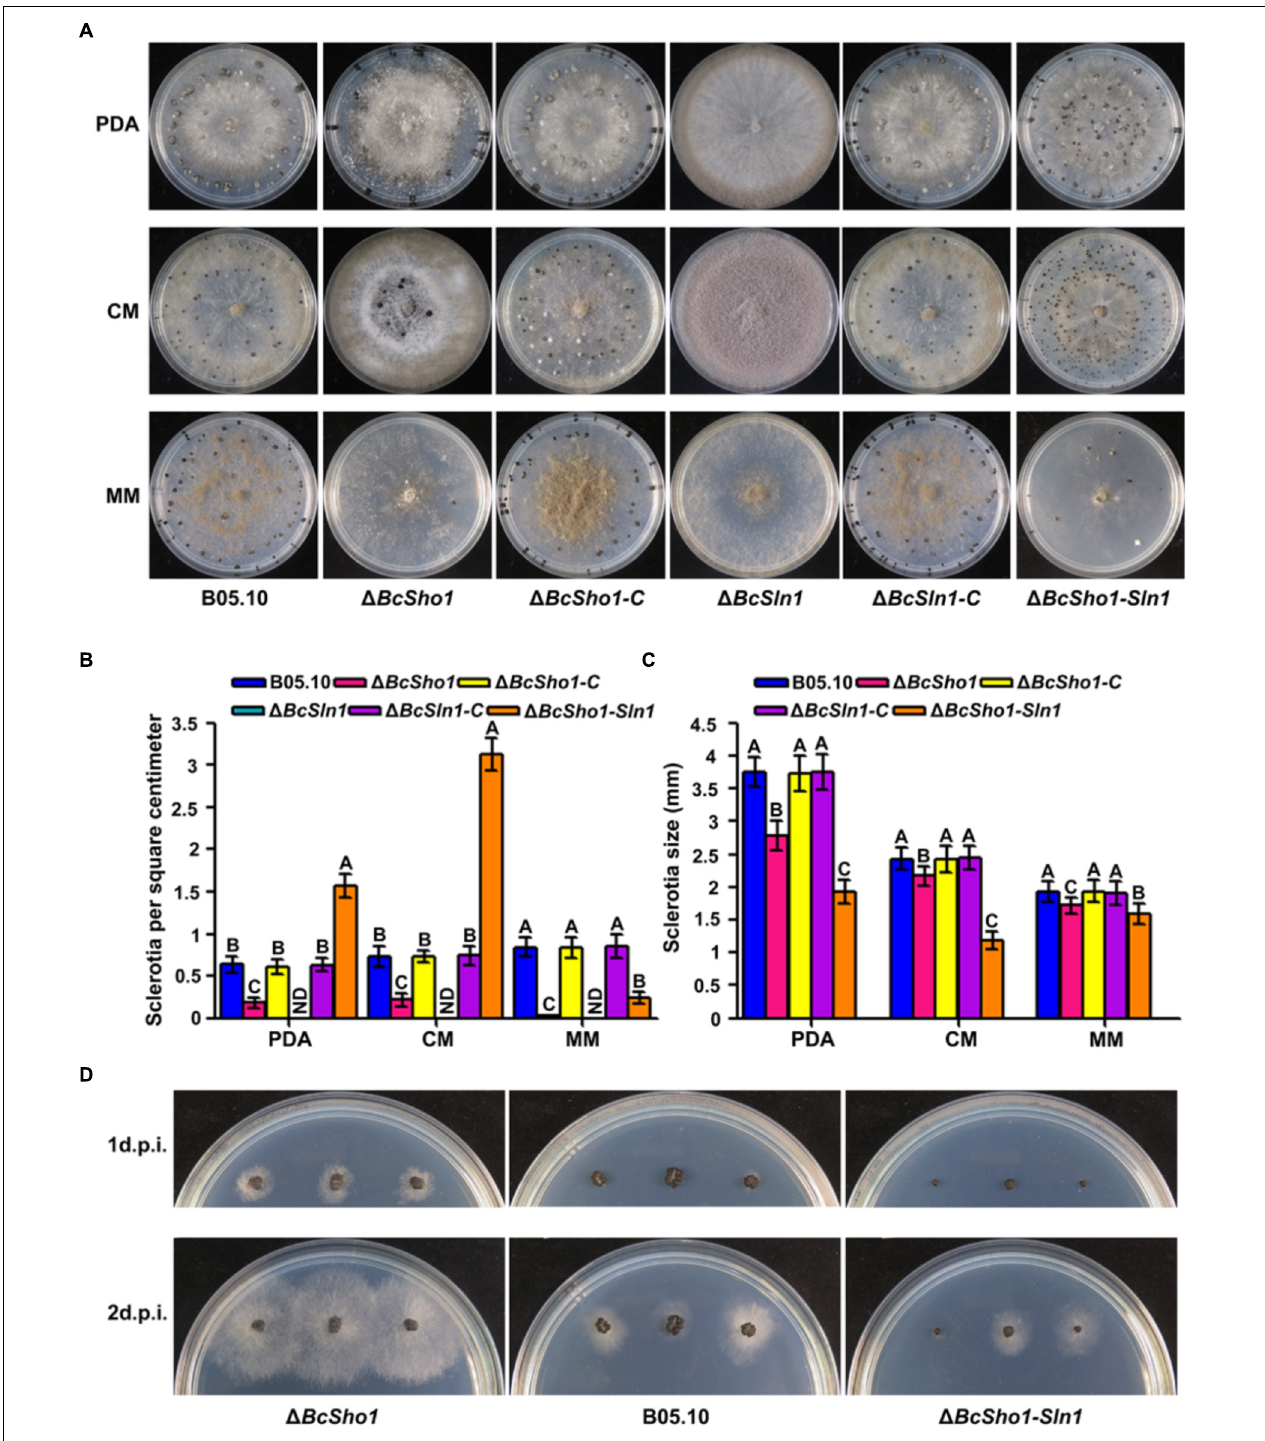
FIGURE 4 | Roles of BcSHO1 and BcSLN1 in sclerotial formation. (A) Colony morphology of sclerotial formation. B05.10, (cid:49) BcSho1 , (cid:49) BcSln1 , (cid:49) BcSln1-Sho1 , (cid:49) BcSho1-C , and (cid:49) BcSln1-C were cultured on PDA, CM and MM media at 4 ◦ C for 4 weeks in darkness. (B) The number of sclerotia produced by each strain on PDA, CM, and MM media. ND, not detected. Bars represent standard errors from three replications. Values on the bars followed by the same letter are not significantly different at P = 0.05. (C) The size of sclerotia produced by each strain. Bars represent standard errors from three replications. Values on the bars followed by the same letter are not significantly different at P = 0.05. (D) Sclerotial germination of each strain on PDA plates at 25 ◦ C at 1 and 2 days post-incubation (d.p.i.).